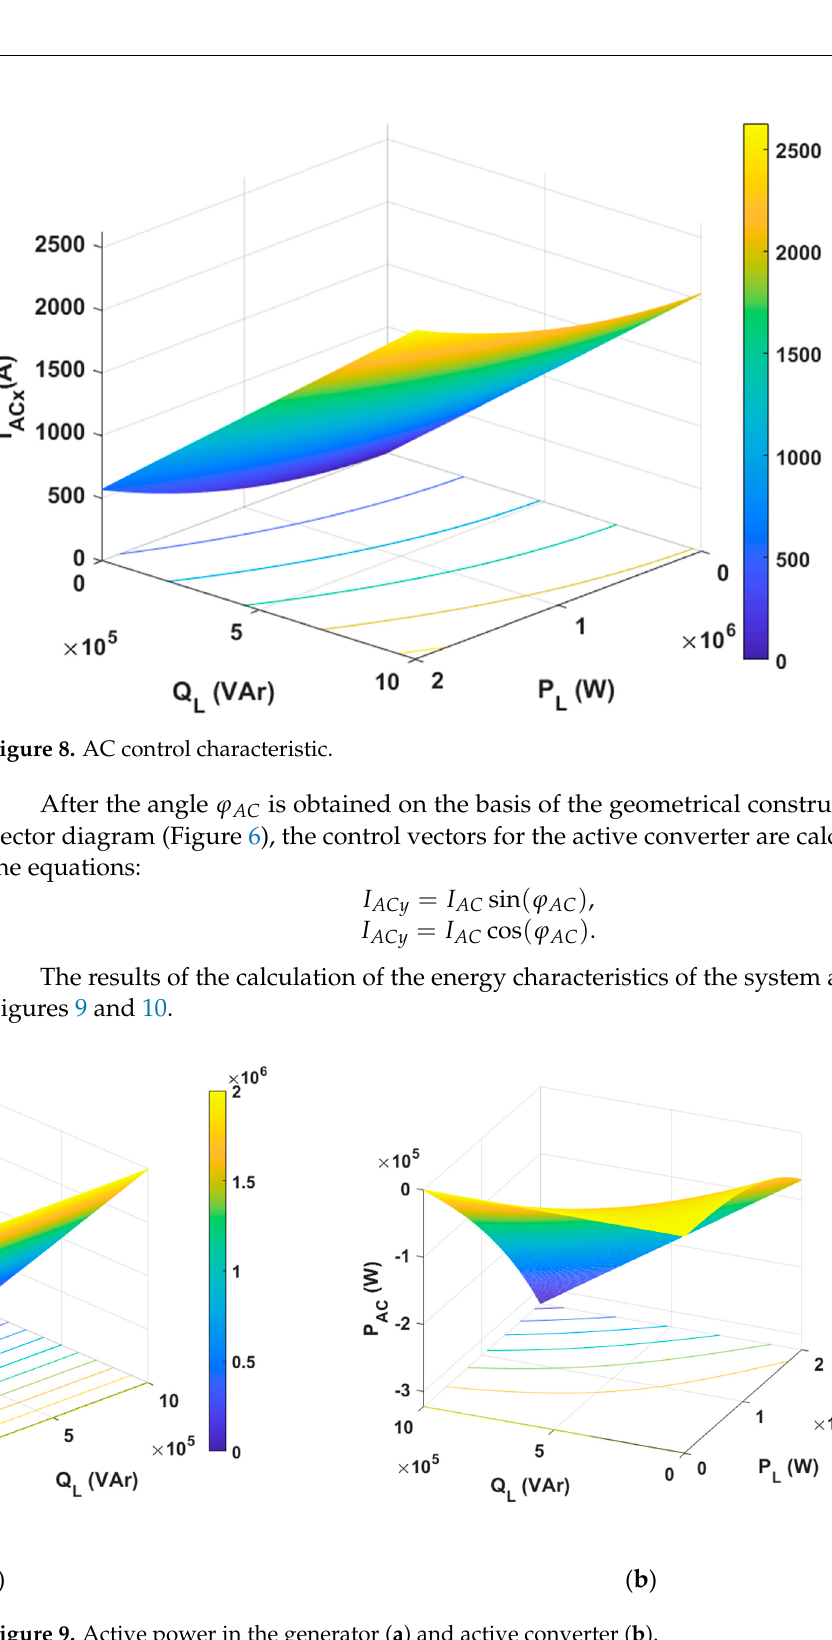
Figure 9. Active power in the generator ( a ) and active converter ( b ).